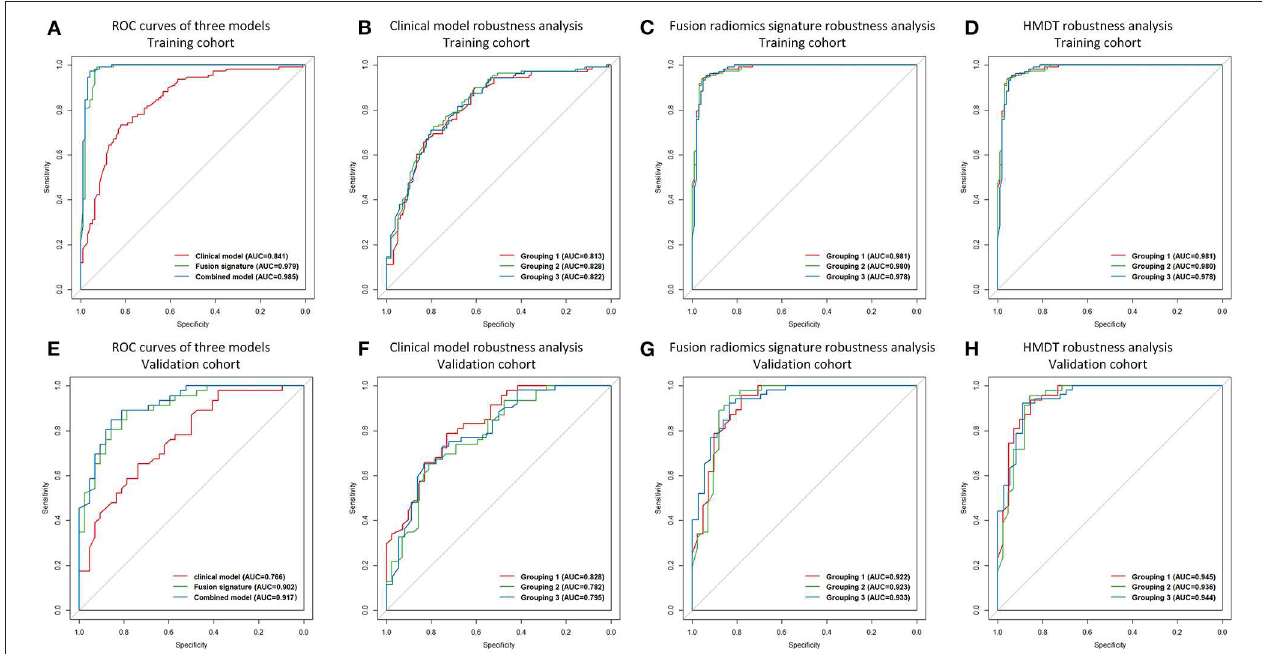
FIGURE 2 | ROC curves and robustness analysis results. ROC curves of the clinical model, the fusion radiomics signature, and the HMDT in the training cohort were shown in (A) , and the ROC curves of the three models in the validation cohort were shown in (E) . Robustness analysis for the clinical model, the fusion radiomics signature, and the HMDT in the training cohort were shown in (B–D) , respectively. For the validation cohort, robustness analysis for the three models were shown in (F–H) , respectively.